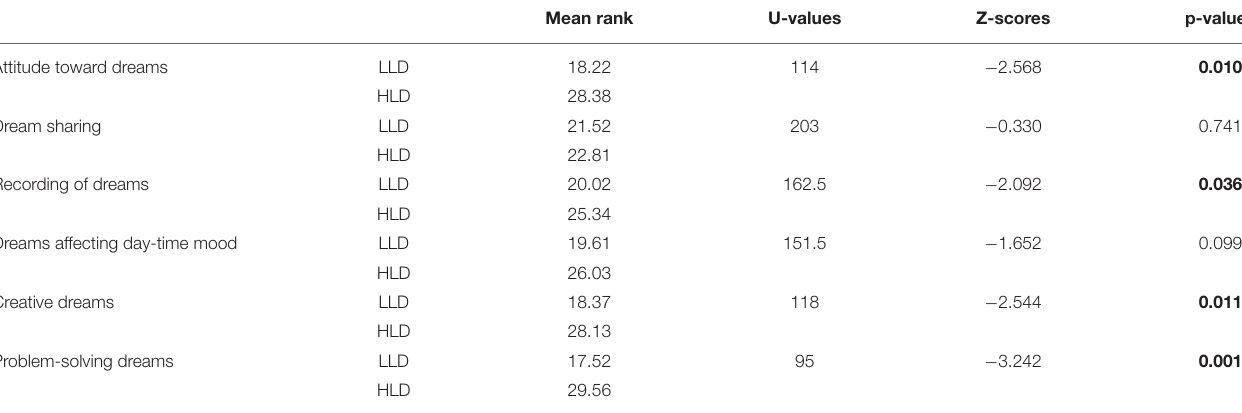
TABLE 4 | Mean rank of attitude toward dreams (averaged score), items regarding utilization of dream during wakefulness and results of statistical comparisons (Mann-Whitney U Test) between narcoleptic patients with low and high lucid